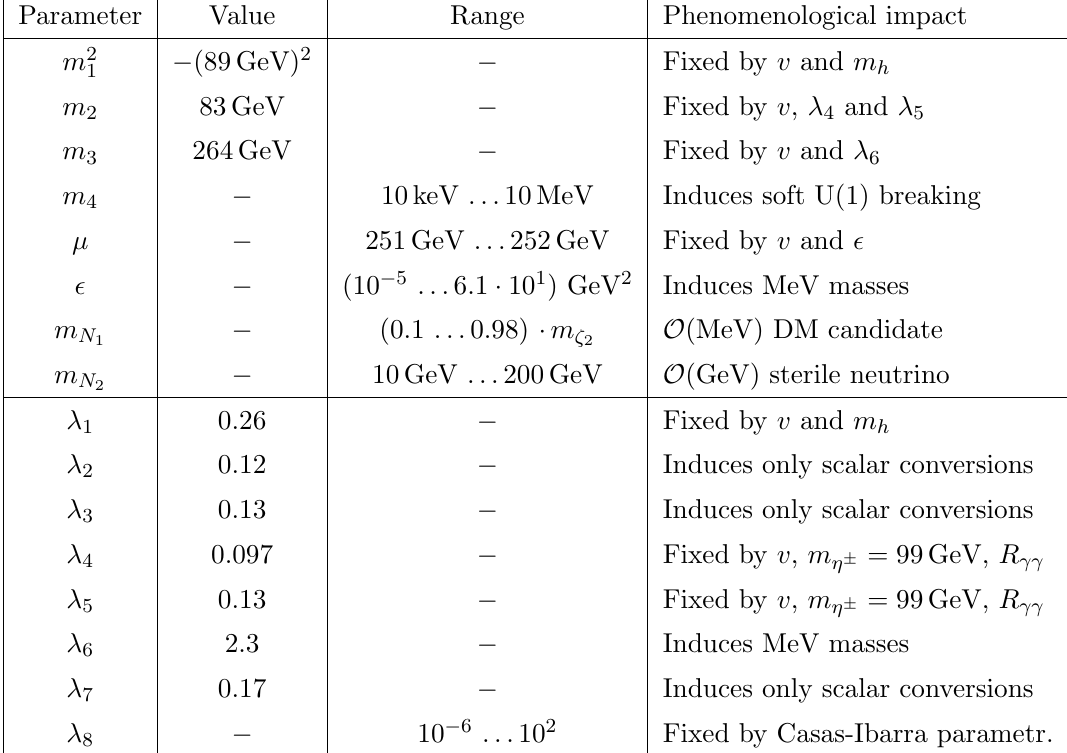
Table 1 . Overview of model parameters with their values or scan ranges and phenomenological impact,